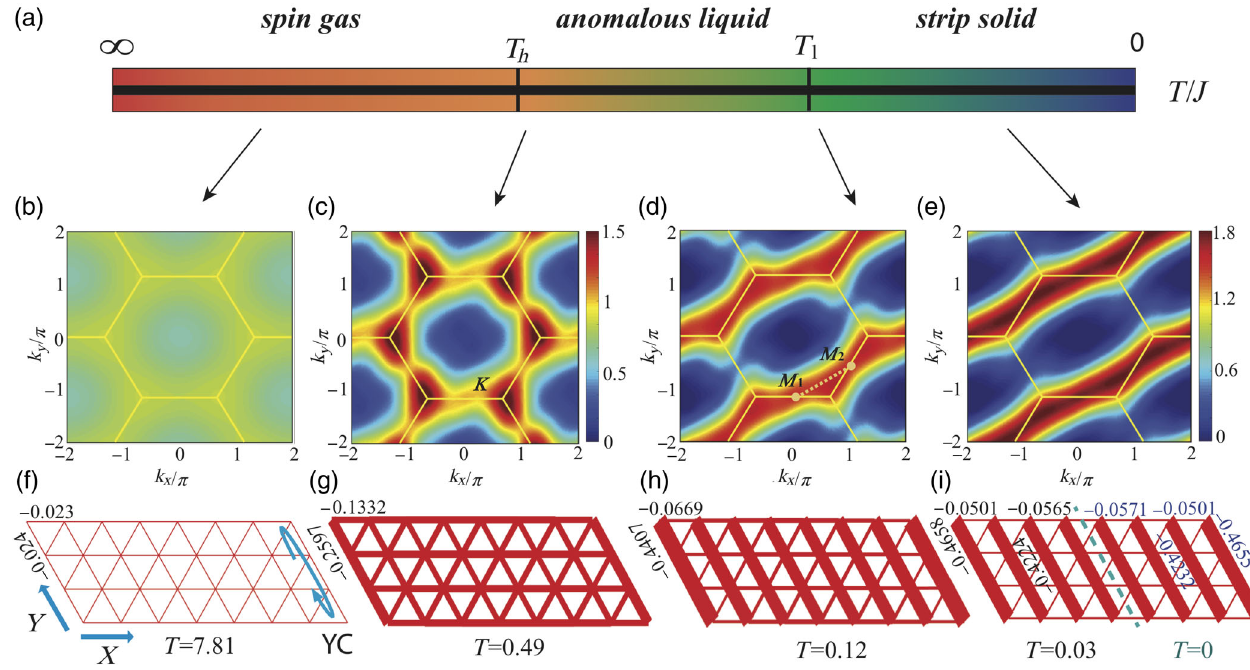
FIG. 9. (a) Finite-temperature phase diagram of TLH on a YC4 lattice, which consists of high- T “ gas, ” intermediate- T liquid, and low- T solid states. (b) – (e) show the static structure factor at four representative temperature points (left to right, from high temperature to low), and (f) – (i) exhibit corresponding bond textures at finite T , and the values are the bond energies to whose absolute value the thickness of nearest-neighbor bonds are proportional. In (i), we also show the bond energy distribution at T ¼ 0 calculated by DMRG, where the agreement between XTRG results (left half) at low- T and DMRG data (right half) is apparent, and one can recognize the strip solid structure quite distinctly. Dashed lines are guide for the eye, representing in (e) the line connecting two inequivalent M points (labeled as M M X and Y directions, as well as the way we wrap the lattice 1 and 2 ) with enhanced intensity. In (f), we label the into a Y